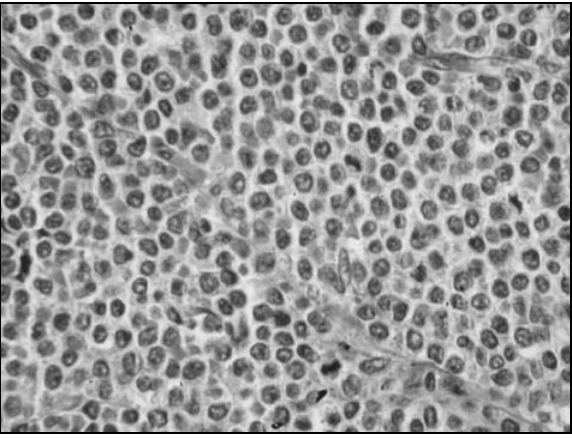
Figura 5 (caso 2) – População de células de tamanho intermediário com freqüentes figuras mitóticas (HE, 400x)